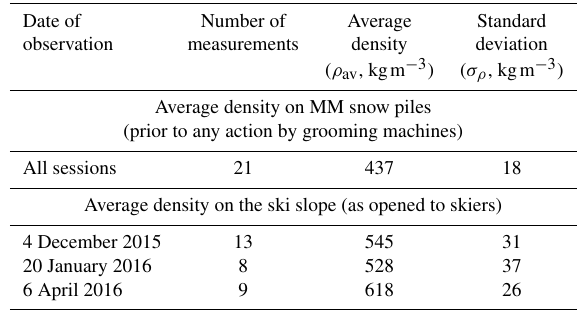
Table 3. Average MM snow density for each session of observations (top) and average snowpack density observed on the ski slope for all three sessions